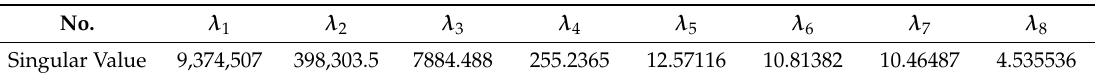
Table 1. Singular value of trajectory matrix.